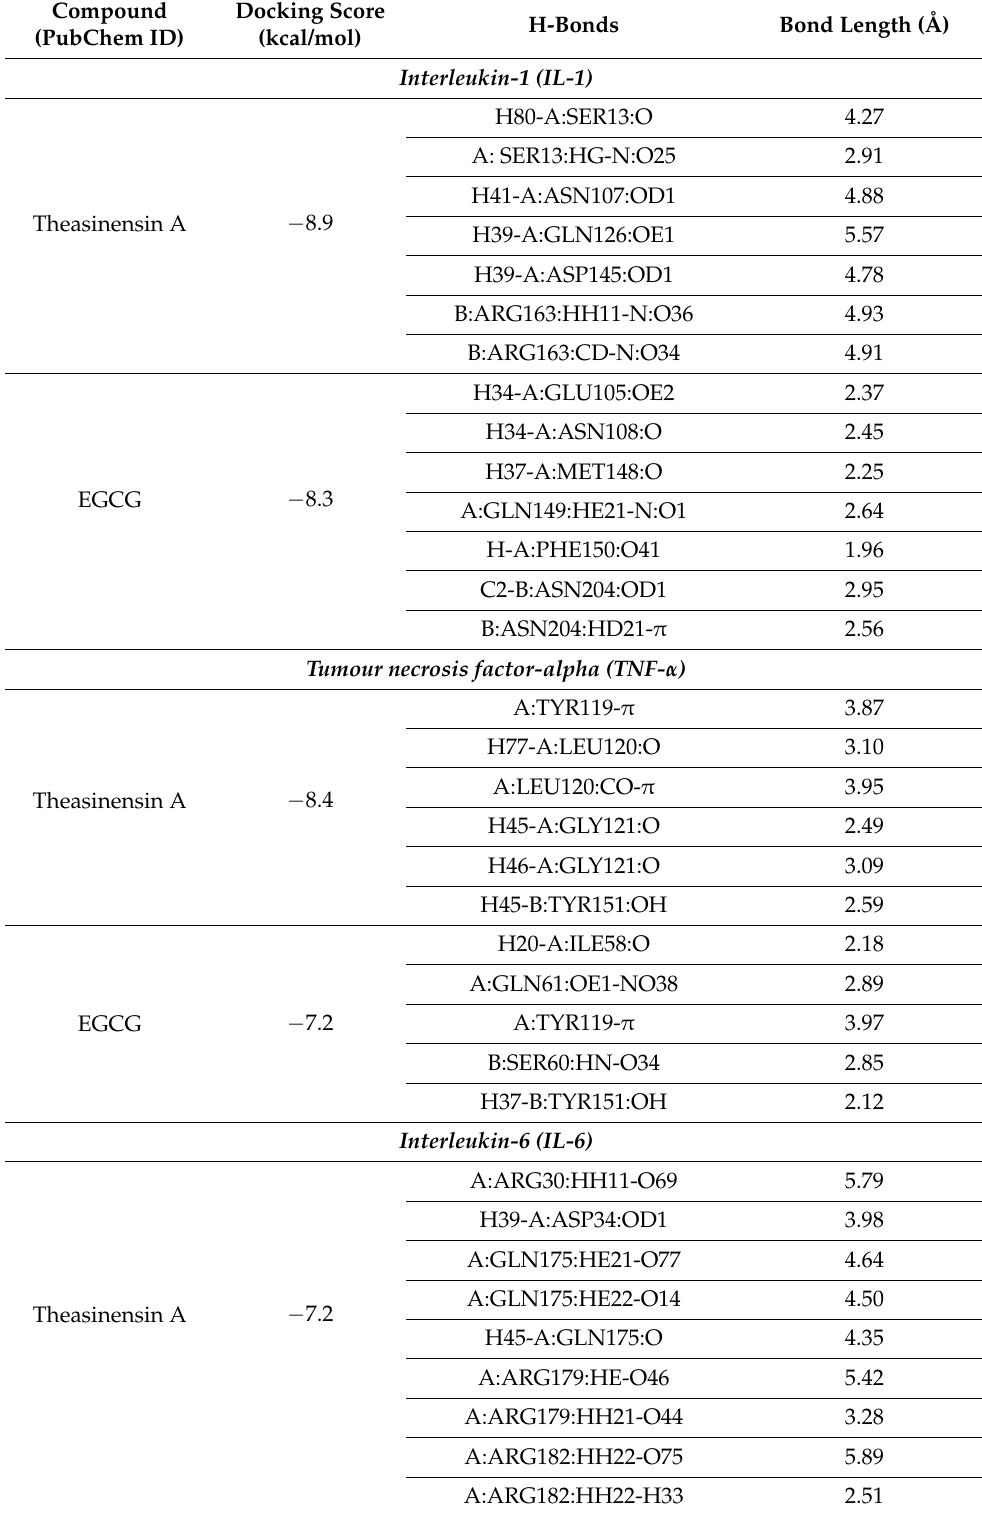
Table 5. Molecular docking score, interactions, and bond length of theasinensin A and epigallocate- chin gallate compounds for anti-inflammatory markers and M pro of